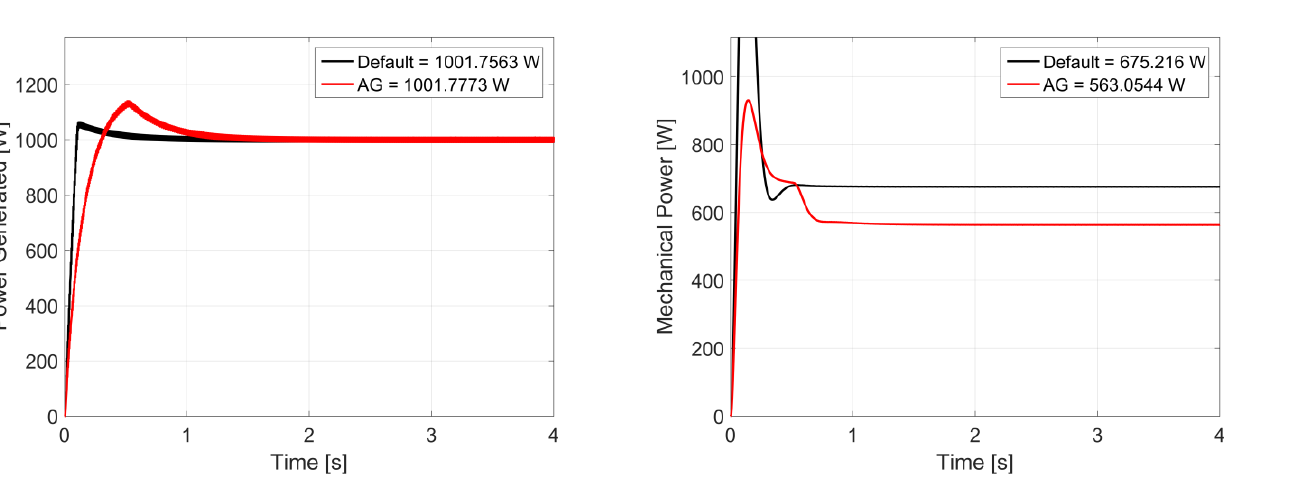
Fig. 7. SRG output power.